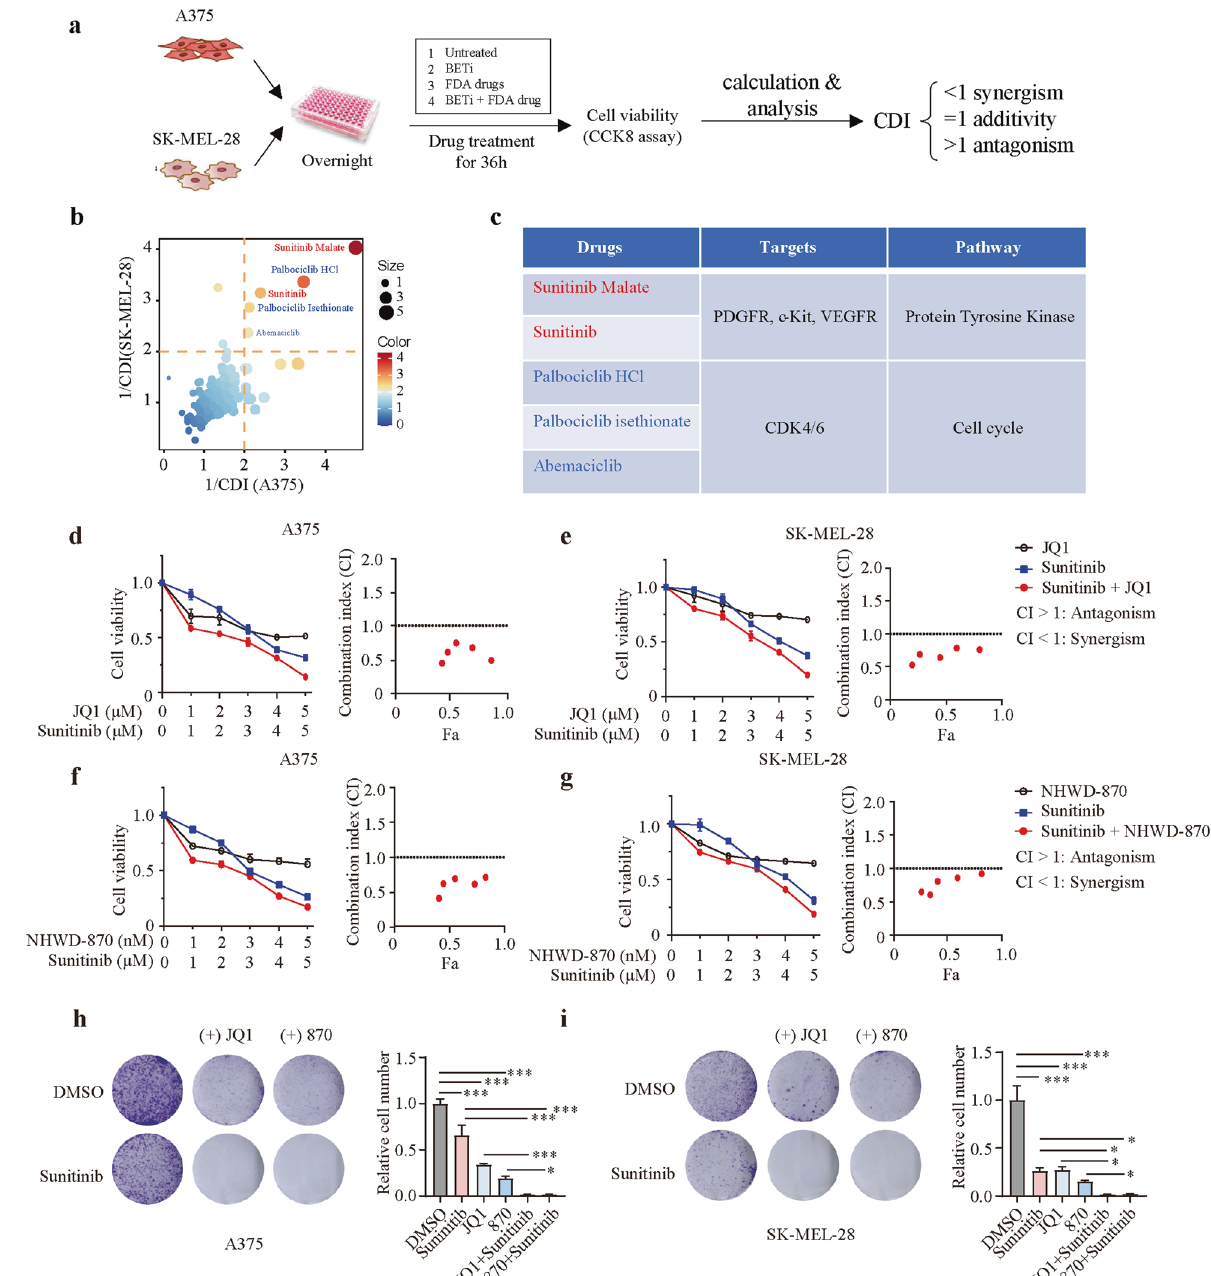
Fig. 1 Identi fi cation of synergy between sunitinib and BET inhibitors in melanoma cells. a Schematic of the screening process for identifying clinically applicable drugs from the FDA-approved drug library that synergize with BET inhibitors in melanoma. b Summary scatter plot of CDI values in A375 and SK-MEL-28 cells. c Targets and targeted pathways of the drugs identi fi ed through the screen. d – g Dose- response curves of melanoma cells treated with sunitinib or JQ1/NHWD-870 either alone or in combination for 36 h (JQ1 and sunitinib at a fi xed ratio of 1:1, NHWD-870 and sunitinib at a fi xed ratio of 1:1000). Synergy was assessed by the Chou-Talalay combination index (CI) for sunitinib and BET inhibitors across the indicated cell lines. The x -axis on the CI plots shows the percentage of cells affected. h , i Colony formation assay of A375 and SK-MEL-28 cells after the indicated treatment. P values were calculated using one-way ANOVA in ( h ) and ( i ). * P < 0.05; *** P <